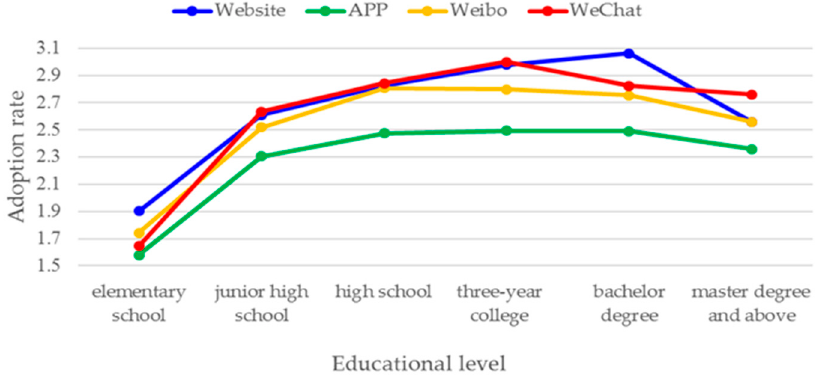
Figure 5. Educational level and adoption of local e-government services.